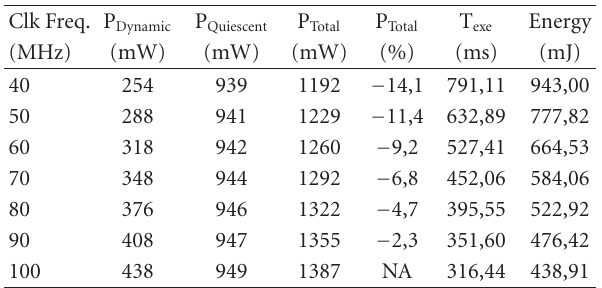
Table 3: Impact of the variation of the clock frequency to the power consumption for V4FX100.